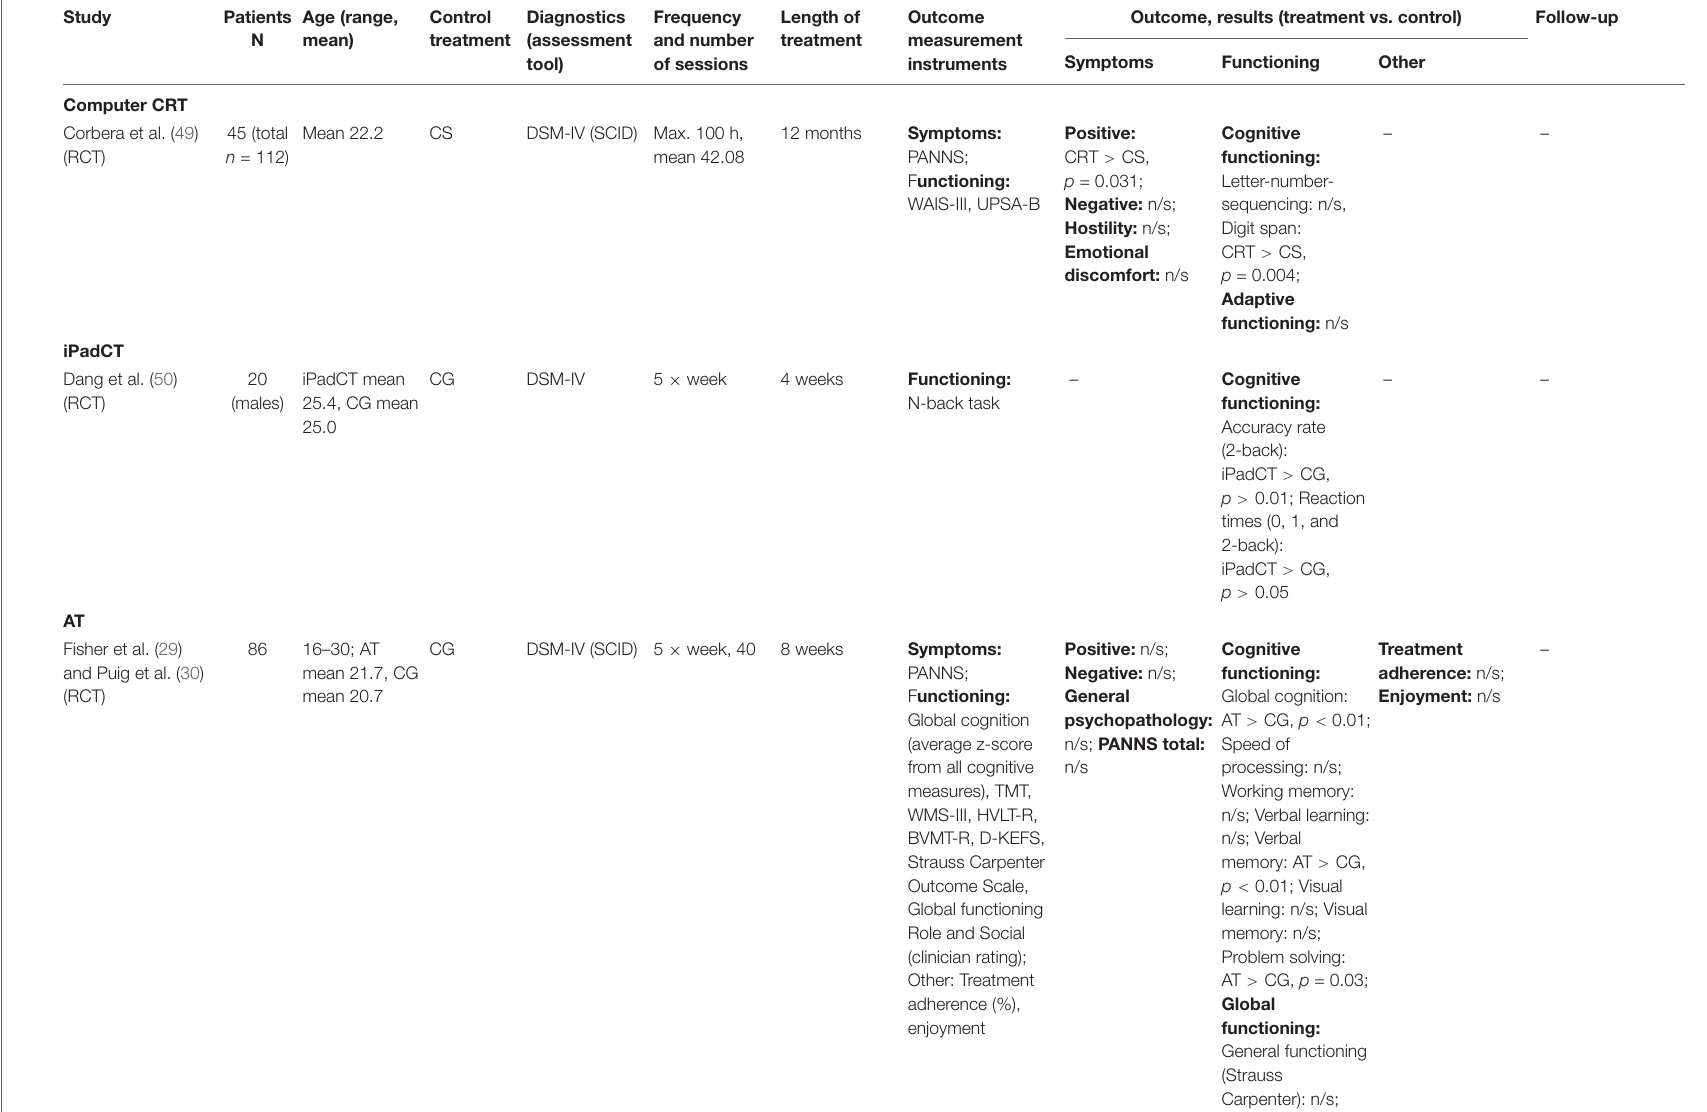
TABLE 3 | Studies concerning psychological interventions based on cognitive remediation for adolescents and young adults with psychosis.